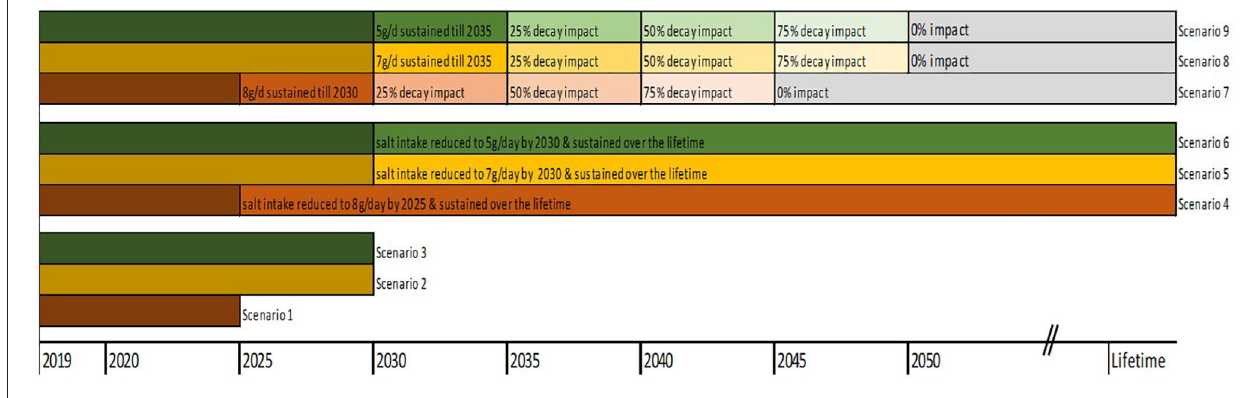
FIGURE 2 | Baseline and scenario analyses of salt reduction targets.